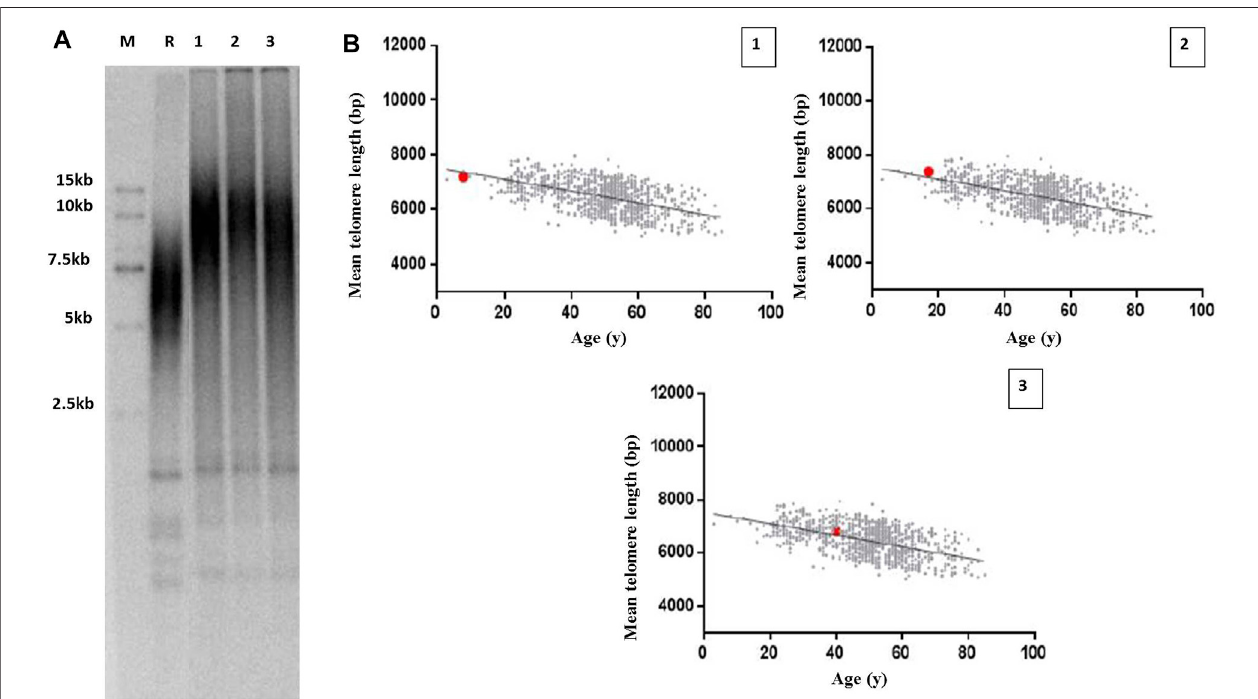
FIGURE 6 | Telomere length measurement in the proband and her family members with TINF2 mutation. (A) Mean leucocyte telomere length was assessed using SouthernblotsanalysisofTRF.M:marker;R:referencestandards;1:theproband;2:thebrotheroftheproband;3:themotheroftheproband. (B) Meantelomerelength was quanti fi ed according to age in the proband and her family members. The Mean telomere length was respectively 7.2 kb in the proband, the 40th percentile of the sameage group(1), 7.38 kb inthebrotherofthe proband, the58th percentile ofthe 17-yearold population (2),and 6.82 kbinthe mother oftheproband,the 60th percentile of the 40-year old population